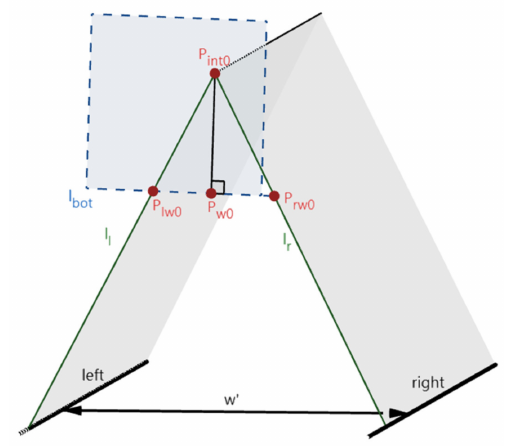
Figure 9. The imaging for the calculation of w’.